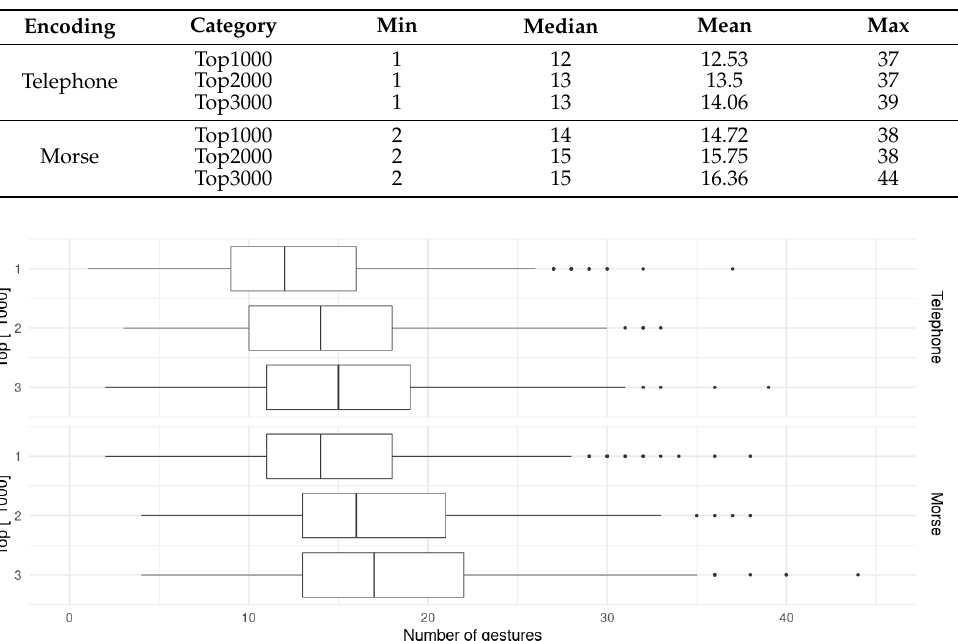
Table 2. Summary statistics of lengths of number of gestures needed.